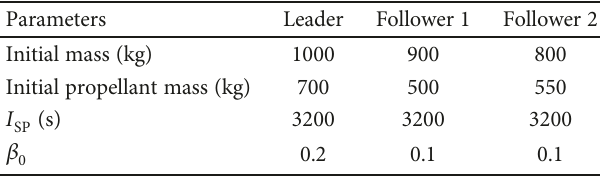
Table 1: Spacecraft parameters.